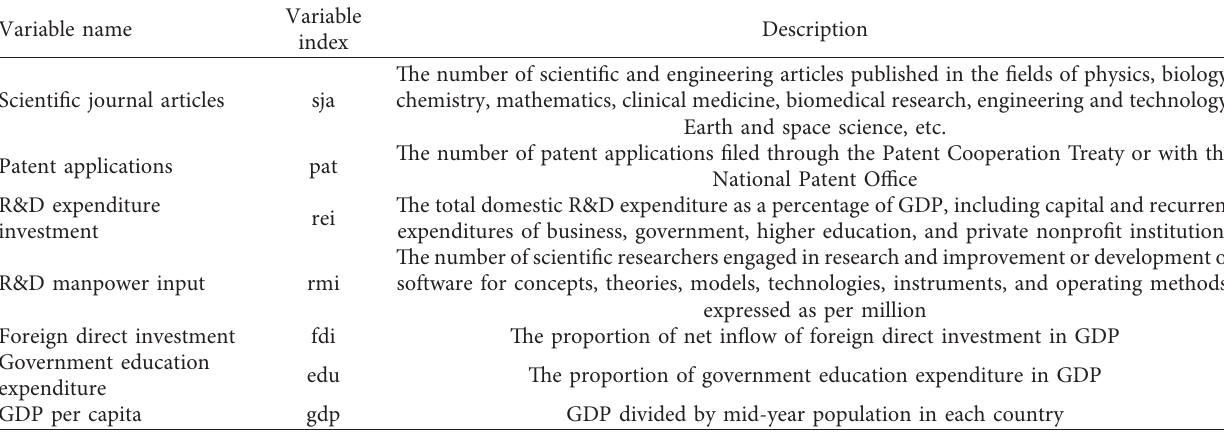
Table 1: Variable settings and